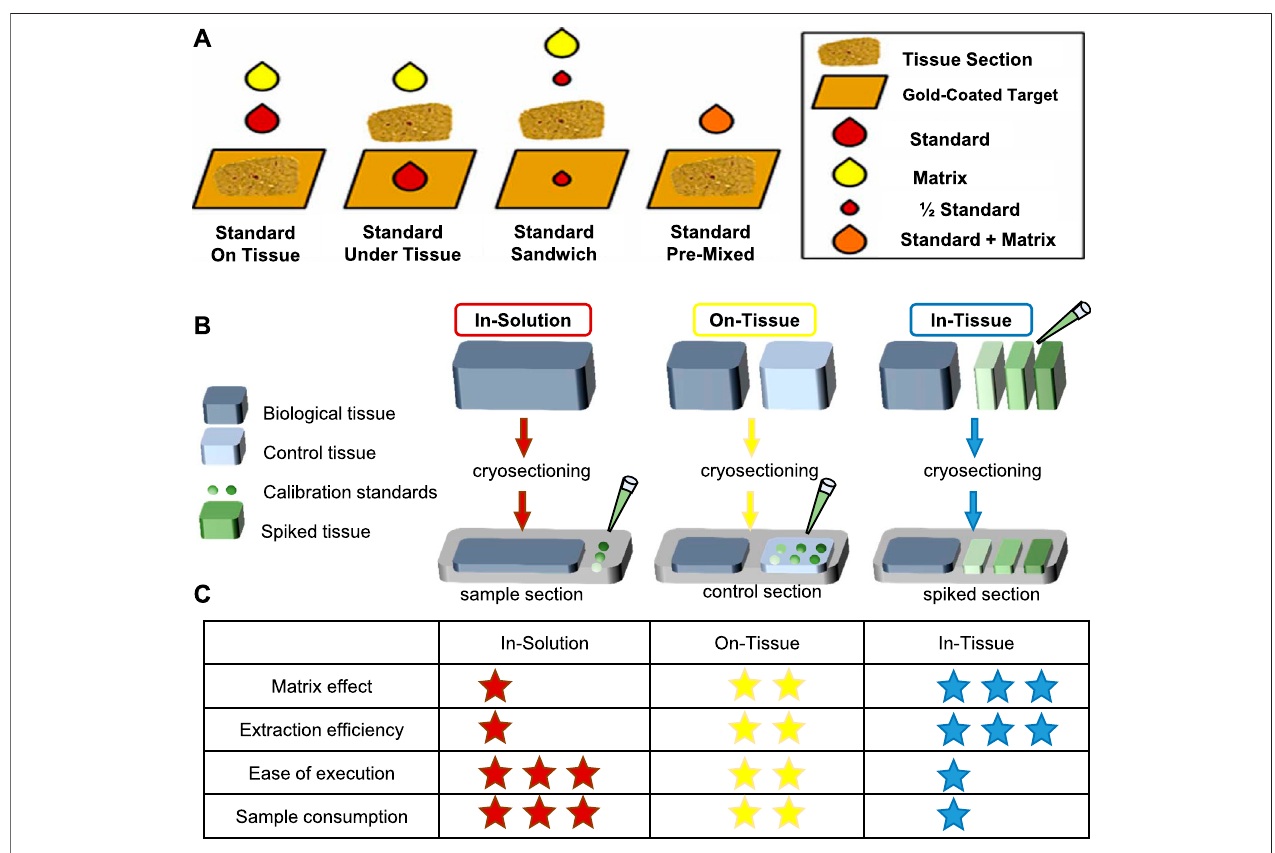
FIGURE 3 | Representative standard applyed methods. (A) Four methods of applied internal standards for MSI (Chumbley et al., 2016). (B, C) Three common methods for calibration of standards applied. Modi fi ed from Porta et al. (2015) and Tobias and Hummon (2020). (B) The in-solution method is to directly spot the calibration standard on the indium tin oxide (ITO) slide. On the other hand, the on-tissue method places acontrol sample next to the sample section and spot calibration standardsonthecontrolsection.Inaddition, thein-tissuemethod usesatissuesimulation modelspikedwithcalibrationstandardsofdifferentconcentrations,and the tissue simulation model is section and placed next to the sample portion. (C) A summary table of the characteristics of each method, where the asterisk indicates performance (low (cid:1) 1 star, high (cid:1) 3 stars).